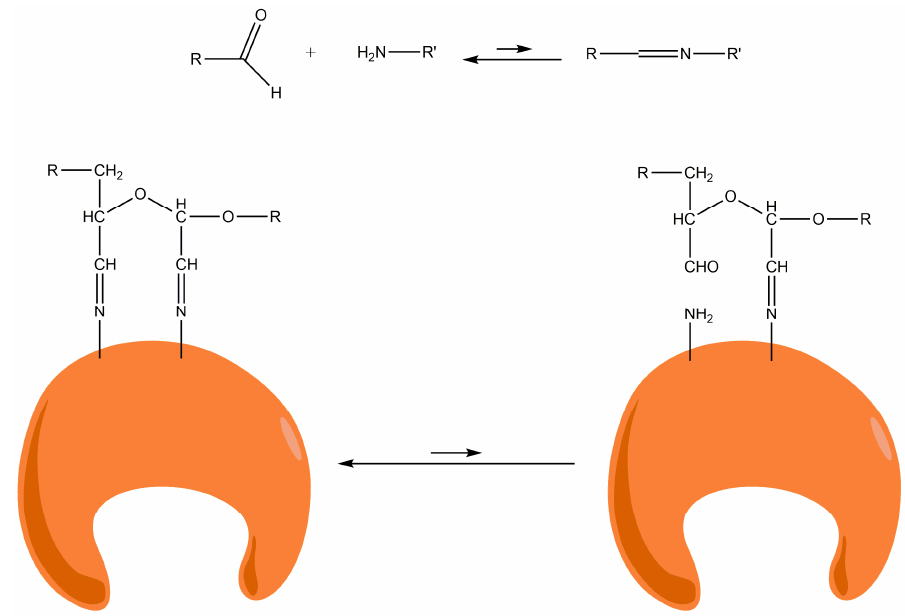
Figure 3. Schematic representation of a very stable attachment involving vicinal unstable Schiff’s bases.